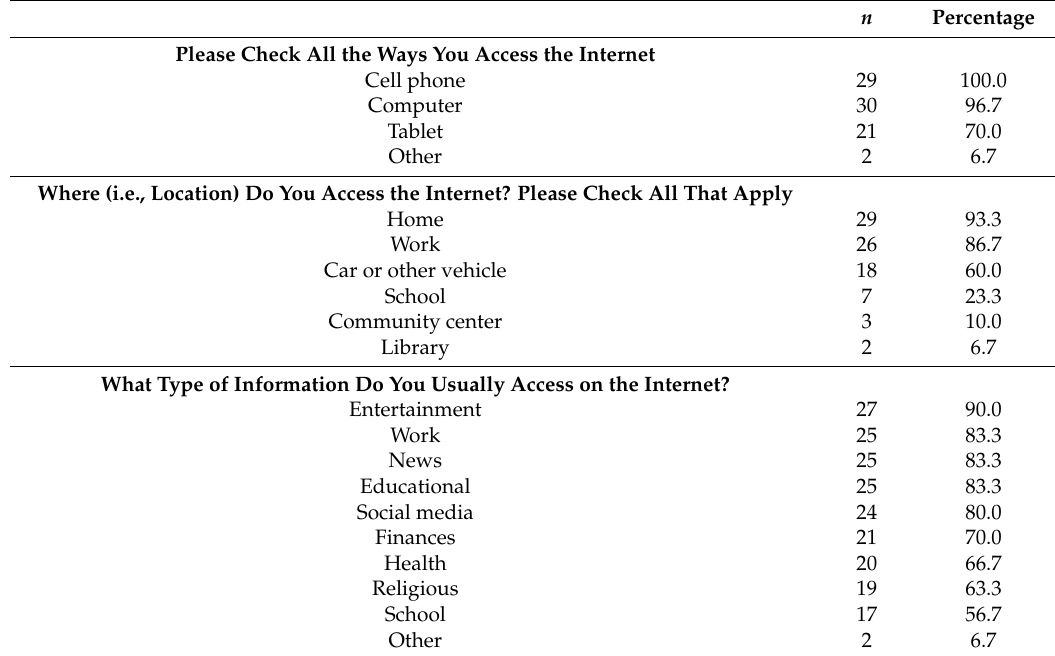
Table 2. Descriptive statistics for Internet usage ( n =